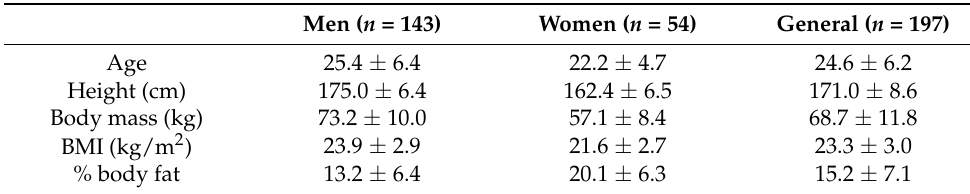
Table 1. Values Mean and standard deviation (SD) of the regression group (RG) for the anthropometric and age of individuals of both sexes.